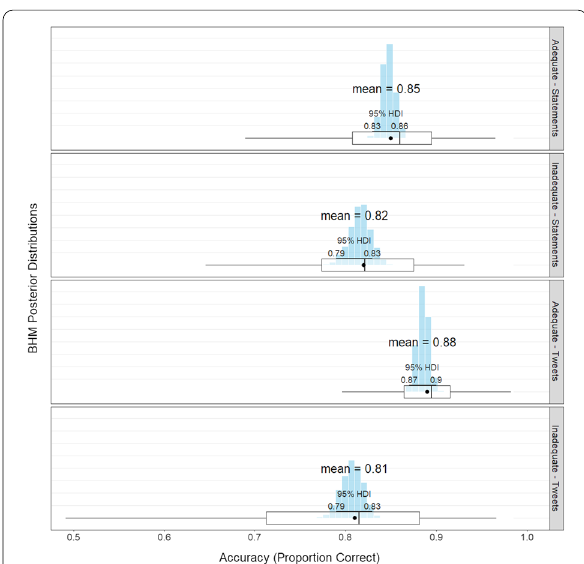
Fig. 4 Accuracy by health literacy and experiment. The blue histograms represents the mean’s posterior distribution. On top is the most likely mean value based on the BHM. In the middle is the 95% highest density interval. At the bottom is a box plot based on the raw data averaged by participant (the black dot represents the raw mean)